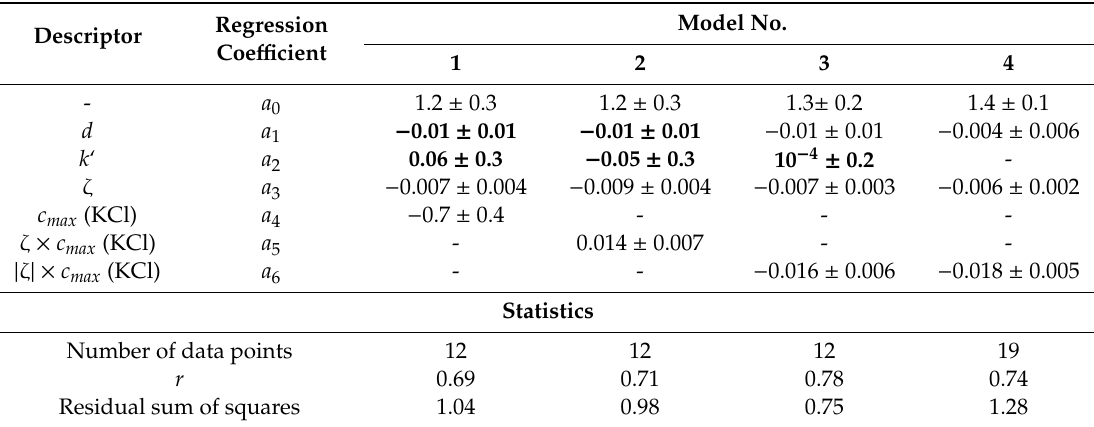
Table 5. Characteristics of QNAR linear models for the prediction of the toxicity of silver NP dispersions to yeast cells; parameter values that failed Student’s t -test ( p > 0.5) are in